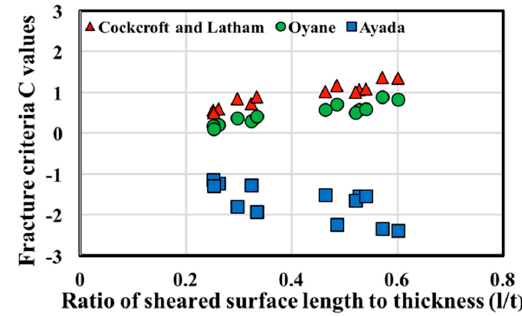
Figure 7. Relationships between the values of fracture criteria and ratio of sheared surface length to thickness obtained by comparing the cutting surface by FEA with the shear limit point ( l/t ) obtained from the punching experiment for the different clearances and different punch diameters.